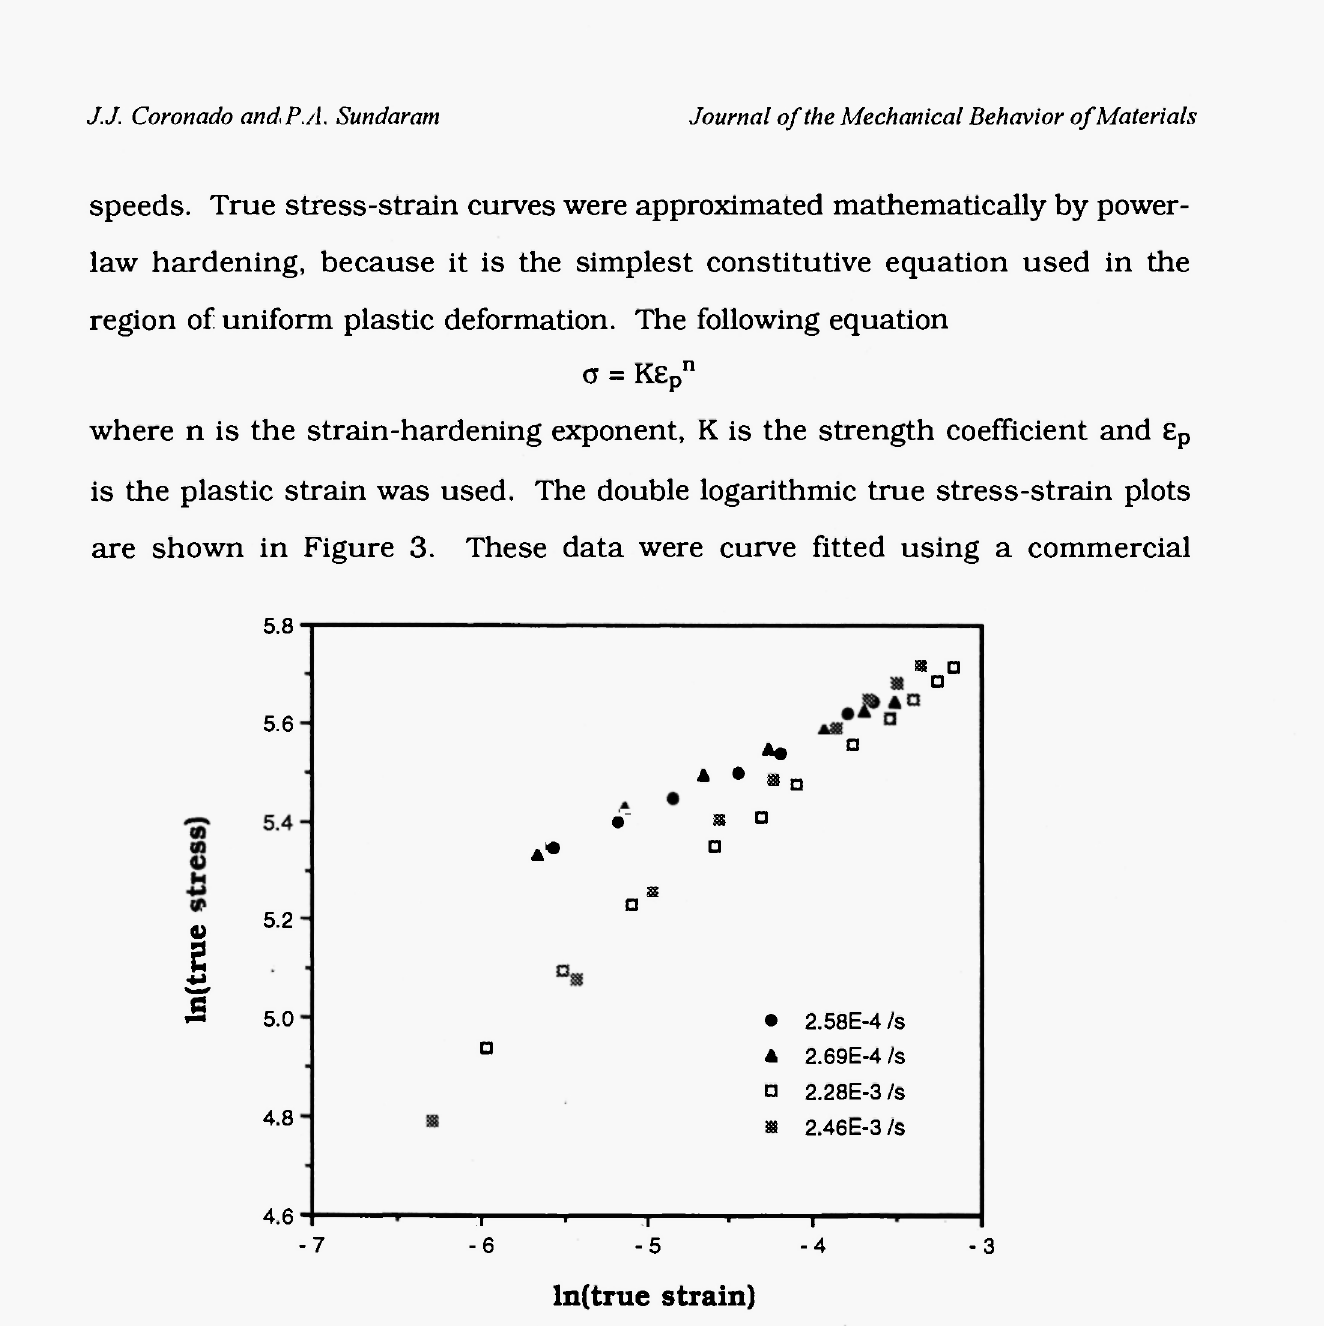
Fig. 3. Double logarithmic curves for the various